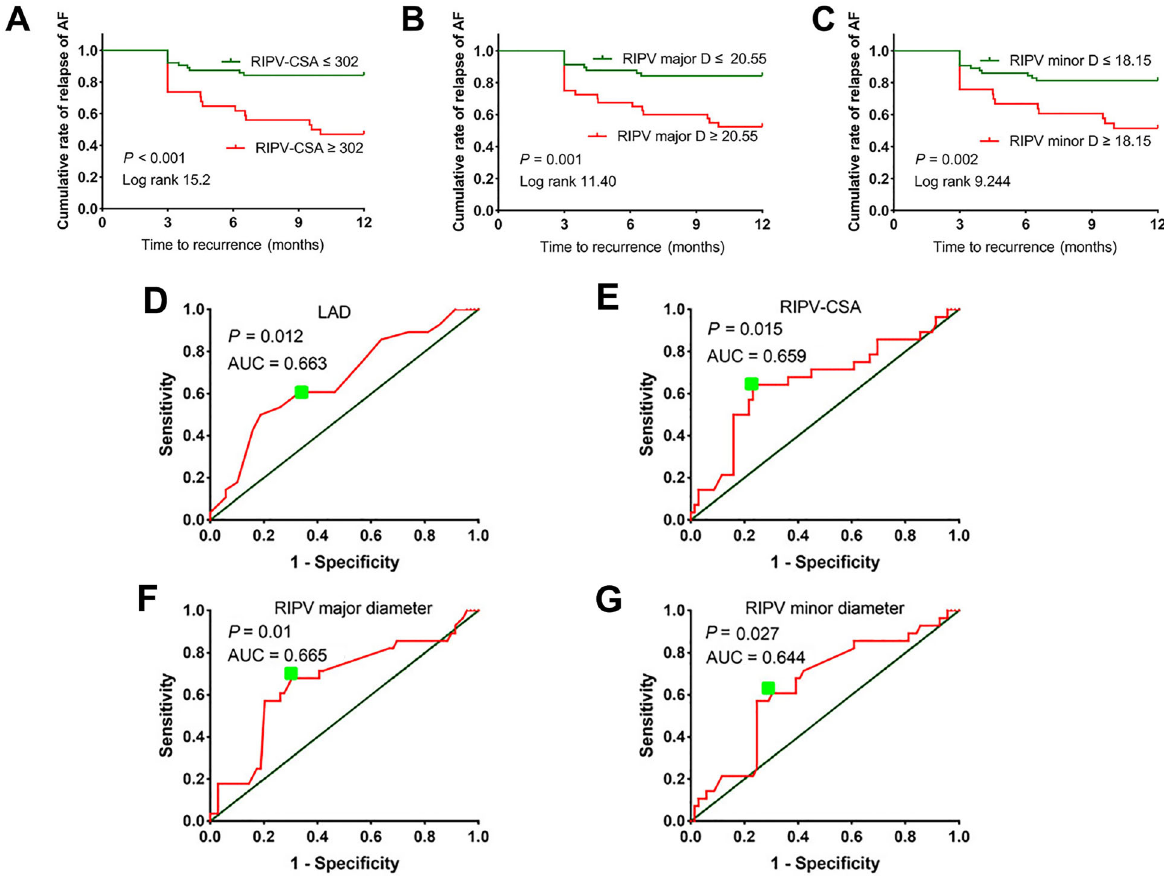
Figure 3. A – C, Cumulative proportional probability of atrial fi brillation (AF) recurrence in patients with a right inferior pulmonary vein (RIPV)-cross-sectional area (CSA) p or 4 302 mm 2 , a RIPV major diameter (D) p or 4 20.55 mm, and a RIPV minor D p or 4 18.15 mm. The optimized cutoff points were obtained from the receiver operating characteristic curves. D – G, Accuracies of left atrial diameter (LAD), RIPV-CSA, RIPV major diameter, and RIPV minor diameter for predicting AF recurrence are reported as areas under the receiver operating characteristic curves